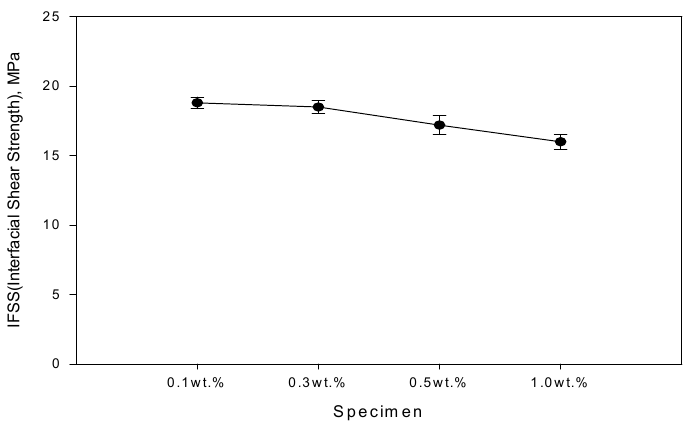
Figure 5. IFSS of epoxy resin according to carbon fiber and pigment concentration .